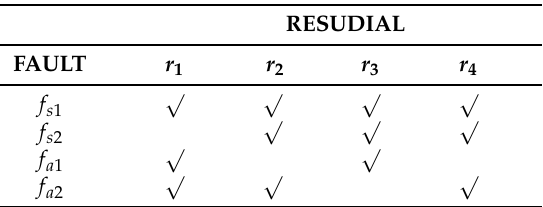
Table 2. Sensitivity of residuals with respect to